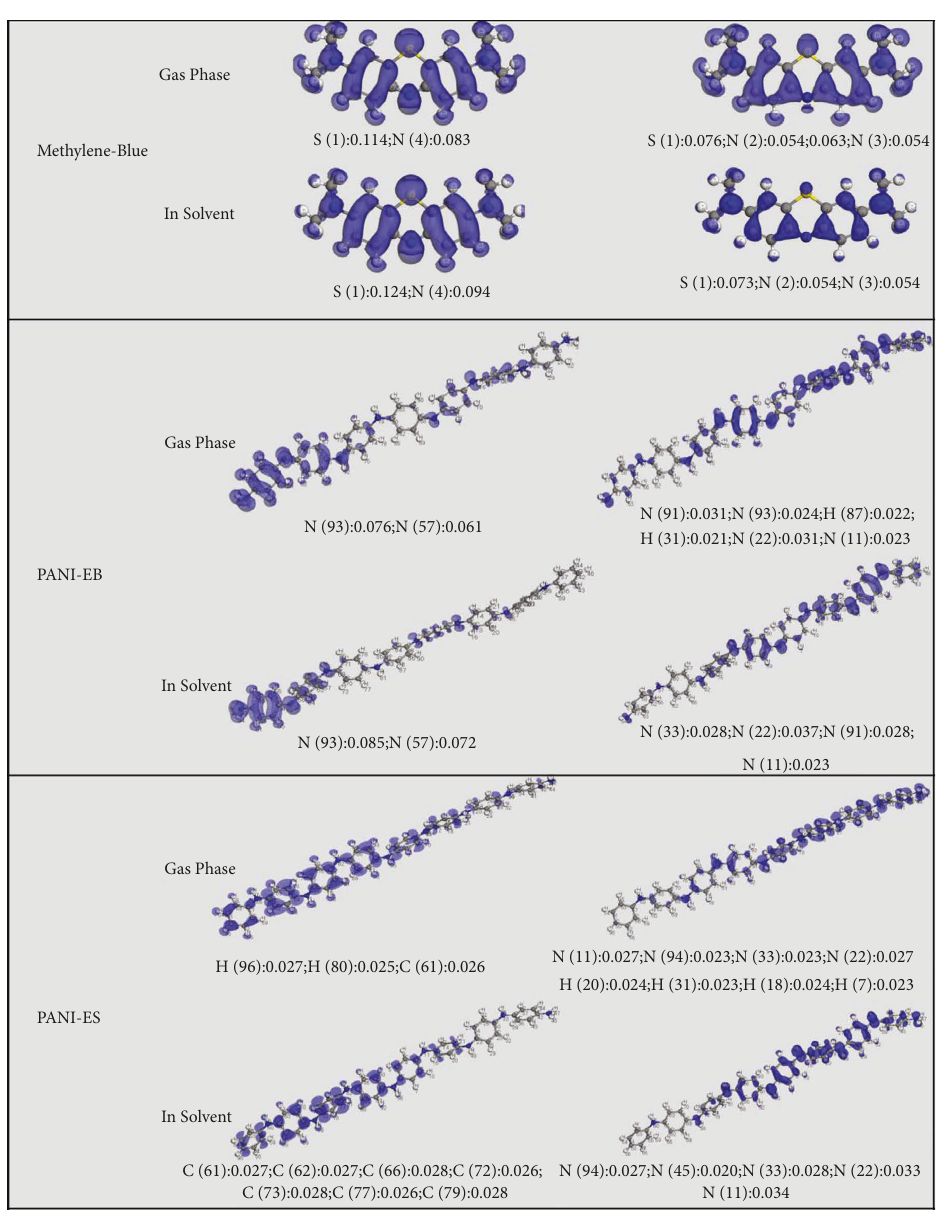
Figure 7: Fukui analysis of MB, PANI-EB, and PANI-ES in the gas phase and liquid phase. The left panel contains values for the nucleophilic term f + k while the second panel gives the electrophilic term f − k values of the Fukui function.